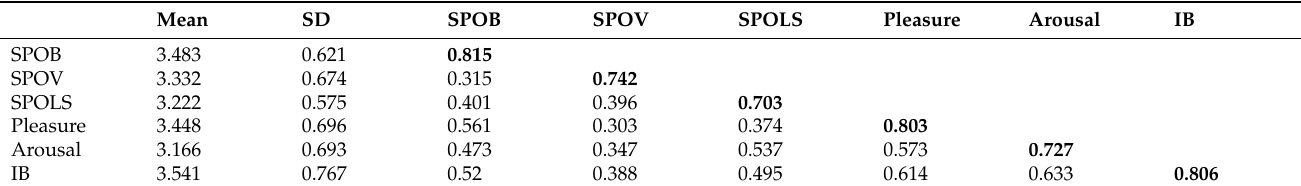
Table 4. Inter-construct